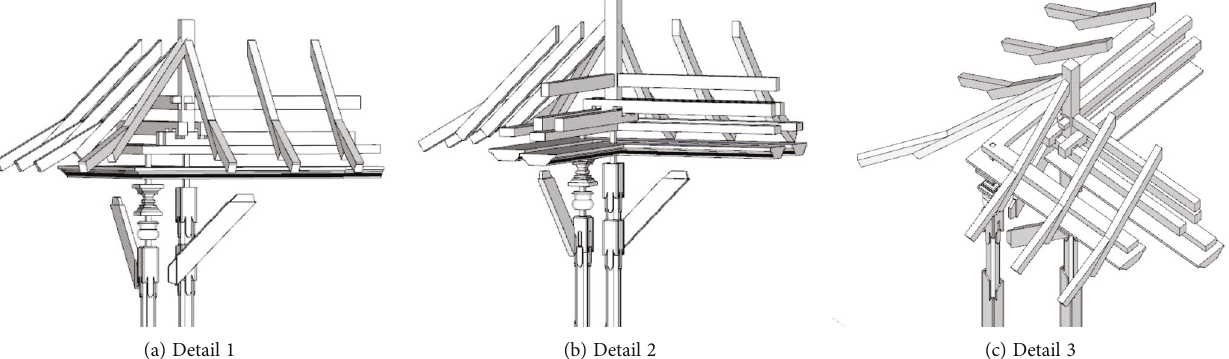
Figure 3: Details of 3D connections as indicated in Figure 2(c).